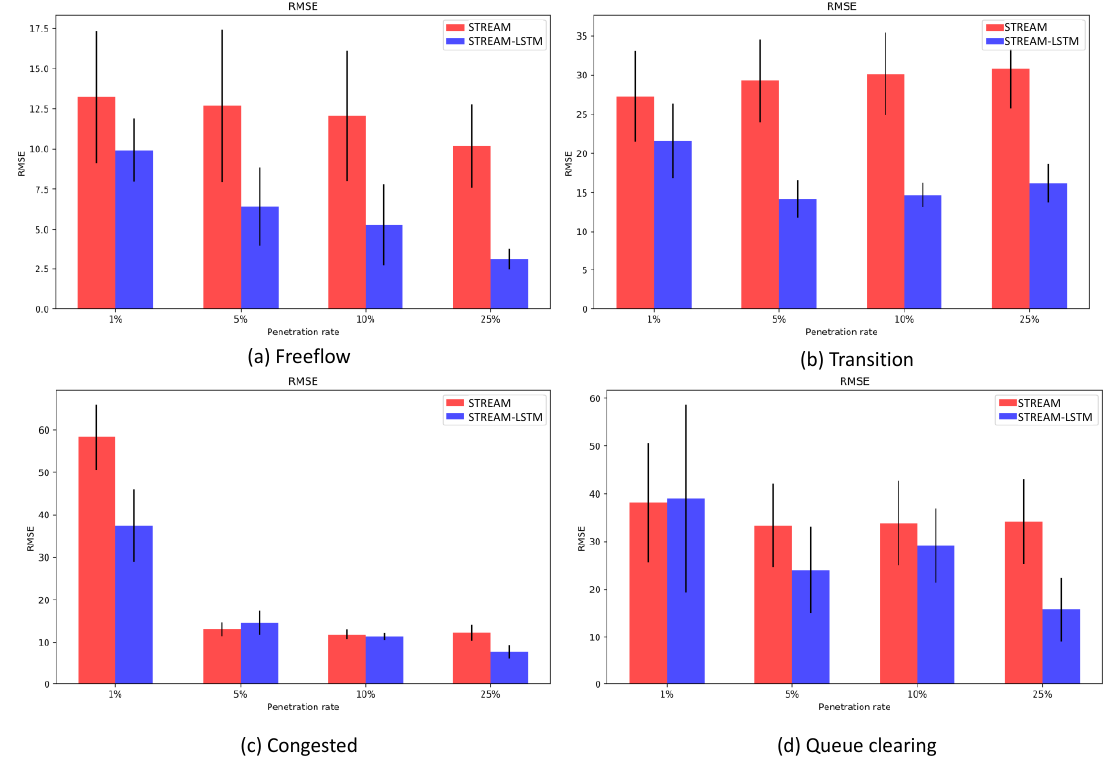
Figure 9. RMSE comparison in different flow regimes. Table 4. Evaluation results for the proposed method (link 13).